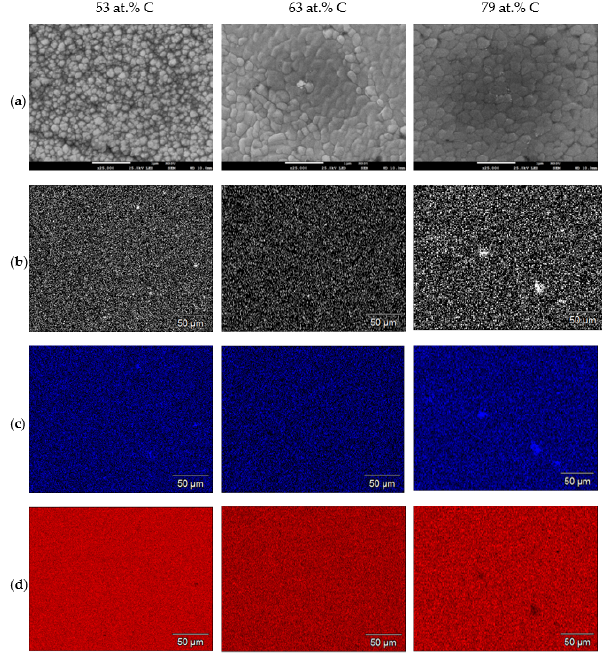
Figure 2. ( a ) SEM micrographs of the surfaces of coatings. ( b – d ) SEM-EDX mapping with a visible element distribution on the surface of samples: (b) O, (c) C, (d) Zr.